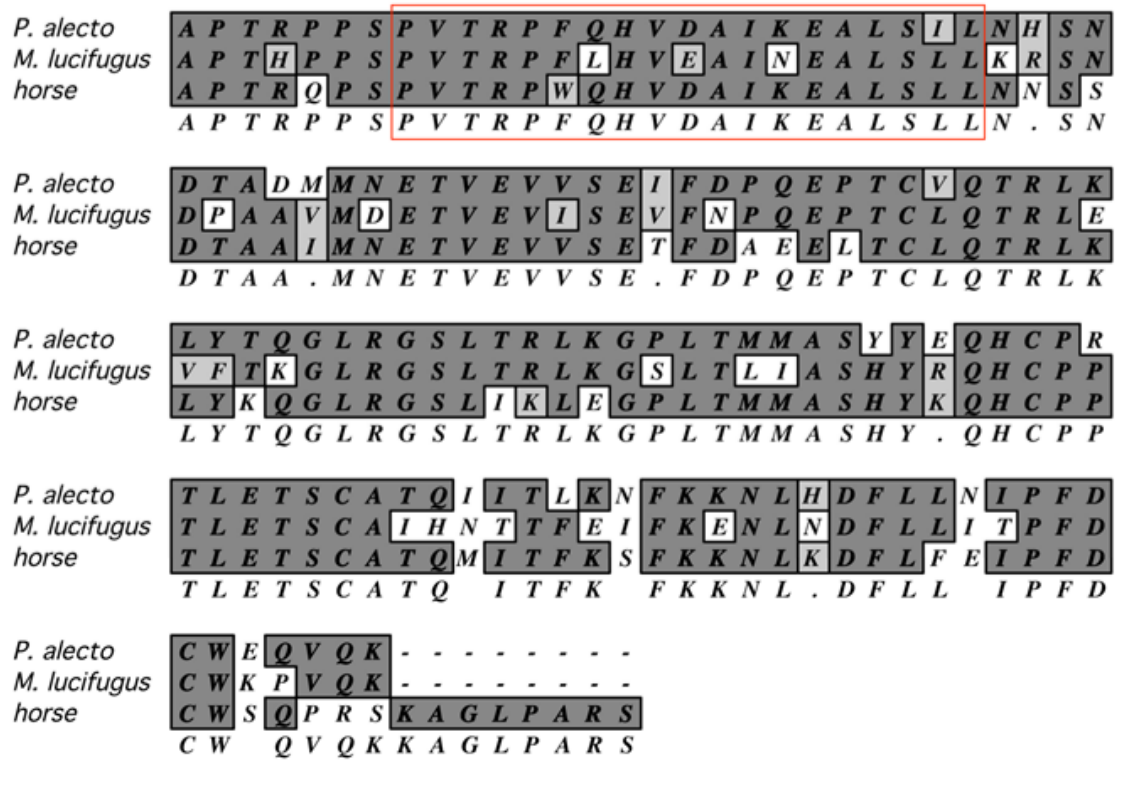
Figure 3. Amino acid alignment of mature GM-CSF from horse, P. alecto and M. lucifugus . Identical amino acids in dark gray, similar amino acids in light gray, and dissimilar amino acids in white, consensus below. The red box is the putative helix A involved in binding to the GM-CSF receptor. Alignment performed with MacVector using the default CLUSTAW settings